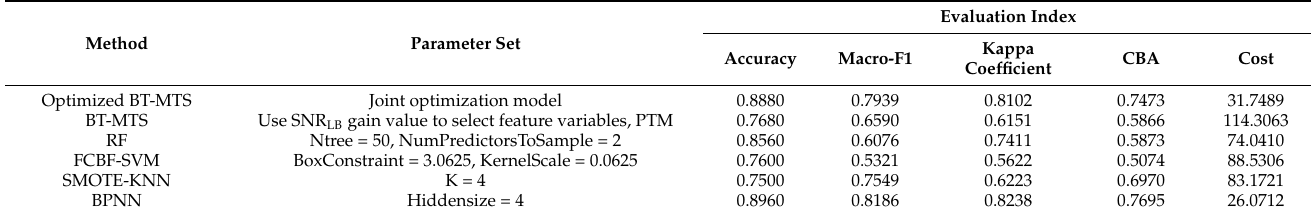
Table 5. Comparison of the classification results of the balance data set.